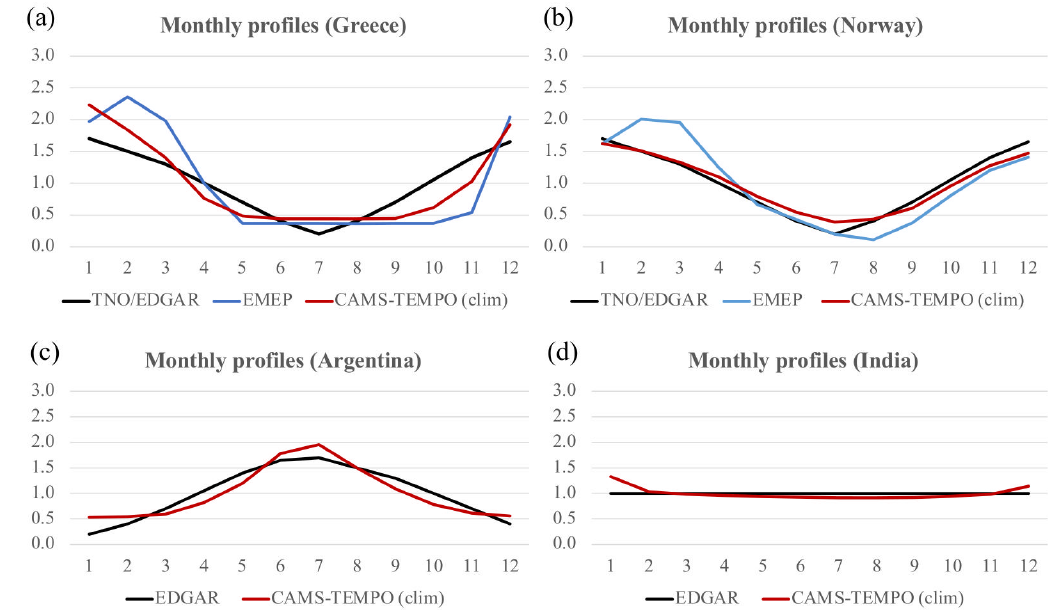
Figure 13. Comparison of monthly profiles for residential and commercial combustion emissions developed in the present work (CAMS- TEMPO) with profiles from EDGAR, EMEP and TNO for selected countries. The CAMS-TEMPO profiles represent the climatological weight factors (clim) based on the average of each month over all the available years